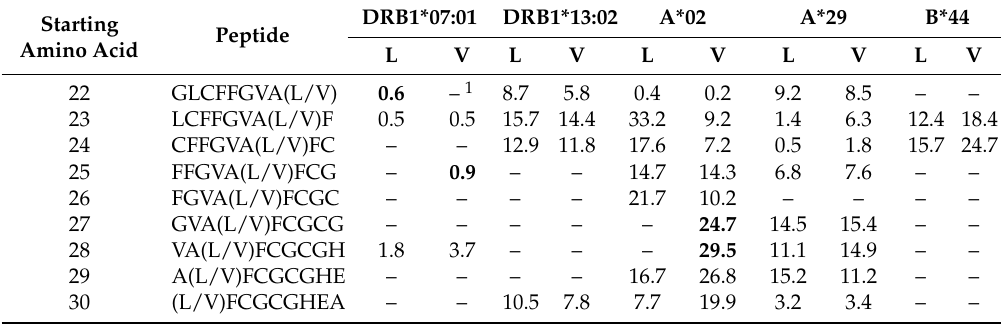
1 indicates a very weak binding affinity of >50 µM.